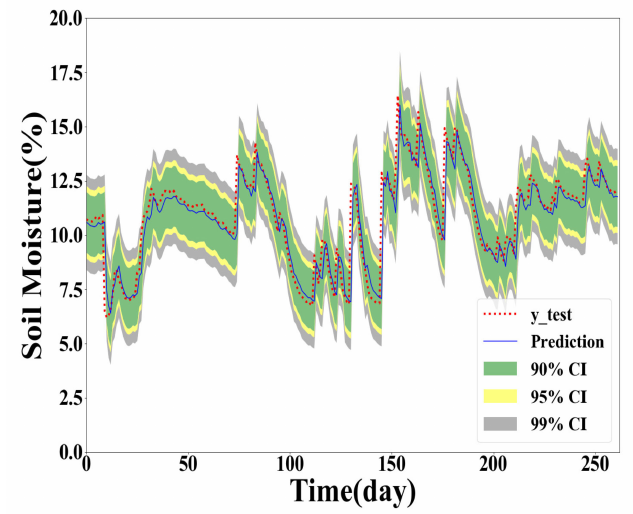
Figure 8. GPR model built with the chosen data in Y(1)